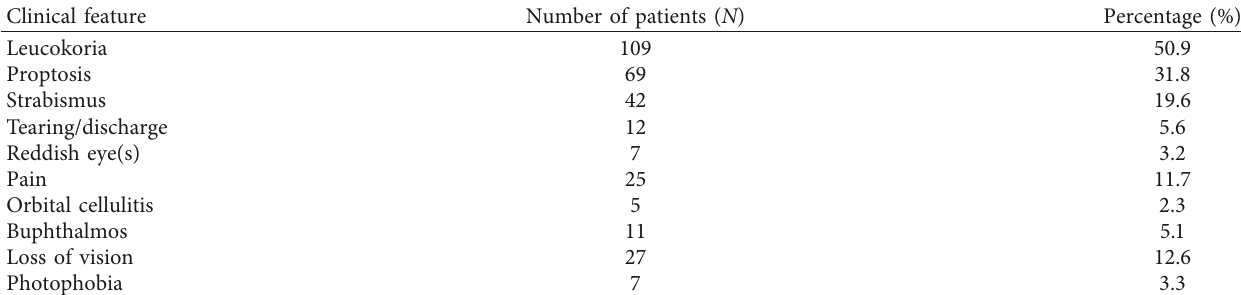
Table 2: Clinical features at presentation in retinoblastoma patients ( n �